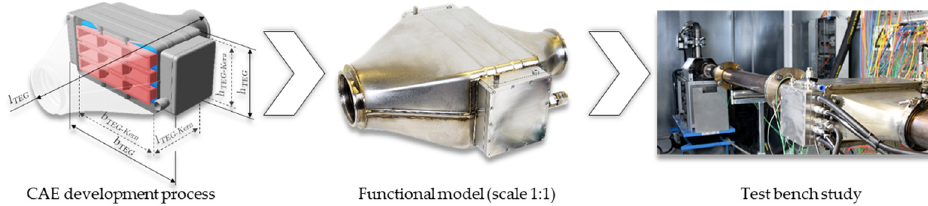
Figure 12. Development process up to test bench investigation of TEG design TCO min.